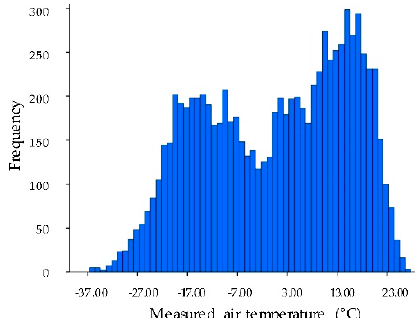
Figure 3. Frequency distribution of measured average 8-day air temperature reference data ( n = 8544) from the 63 automatic weather stations for the years 2002–2017. Monthly statistics are depicted in Table 2.